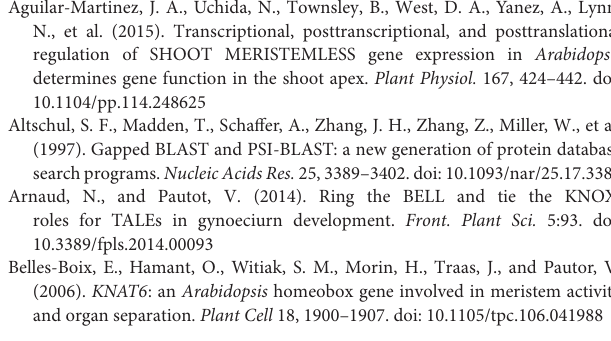
Supplementary Table 1 | RT-PCR primers used to detect the expression of KNOX genes in Physcomitrella and Selaginella. Supplementary Table 2 | Excel spreadsheet with G. max expression data. Supplementary Data Sheet 1 | Alignment of 394 KNOX protein sequences.